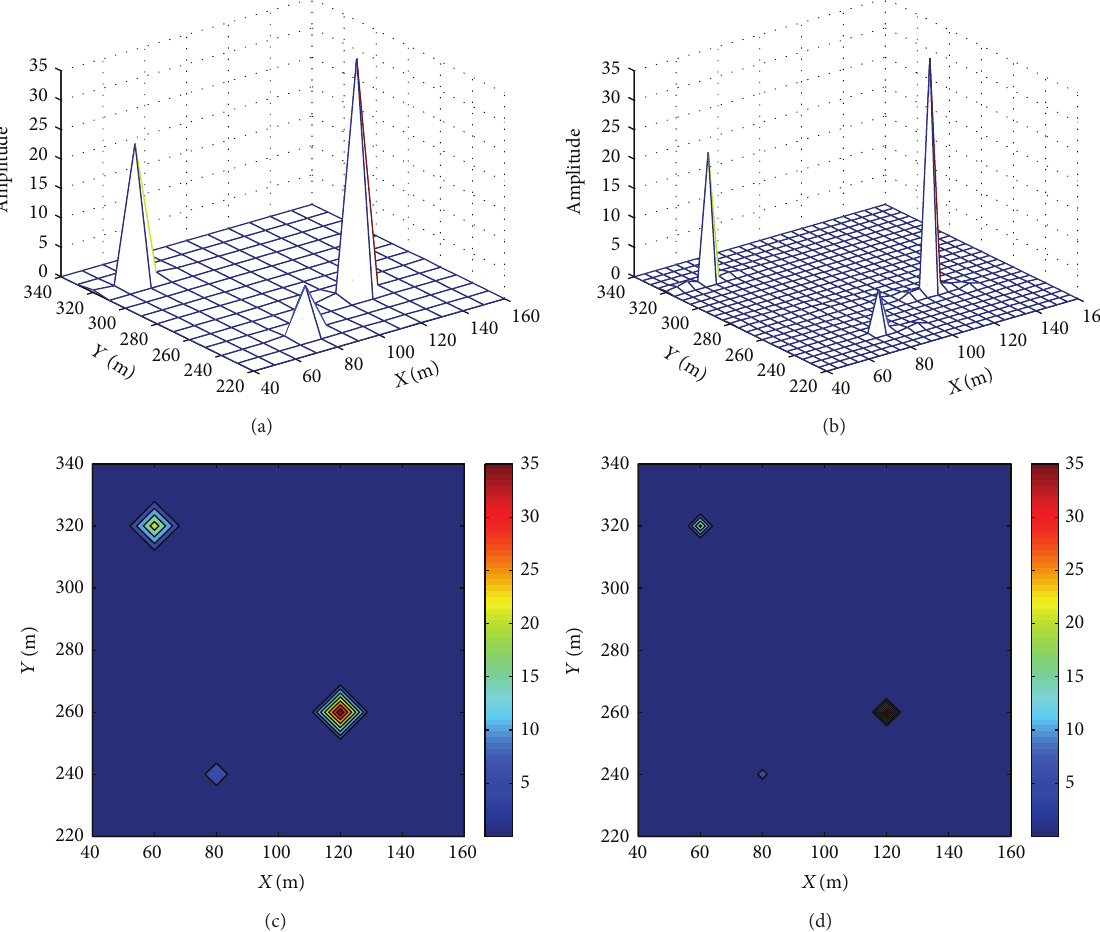
Figure 7: Comparison of reconstructed target reflection coefficients using BSBL- ℓ 1 method with different grid distance. SNR = 10 dB. (a) Grid distance is 10m (3-D), (b) grid distance is 5 m (3-D), (c) grid distance is 10 m (contour plot), and (d) grid distance is 5 m (contour plot).